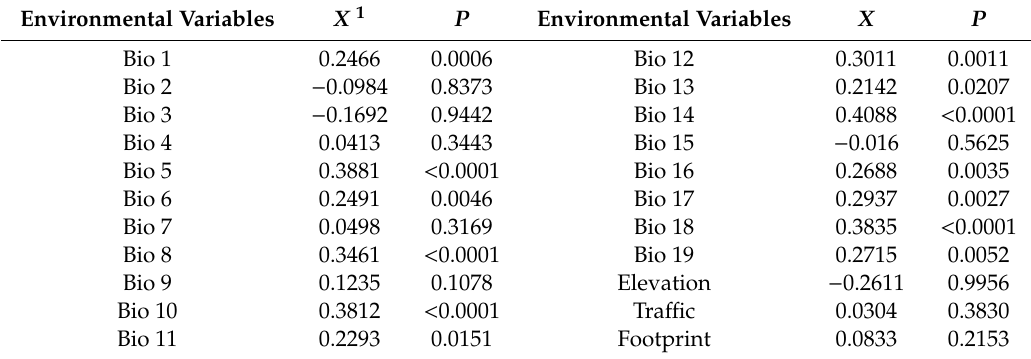
Table 2. Spatial association between the 22 environmental variables and the possible presence of R. shantungensis in